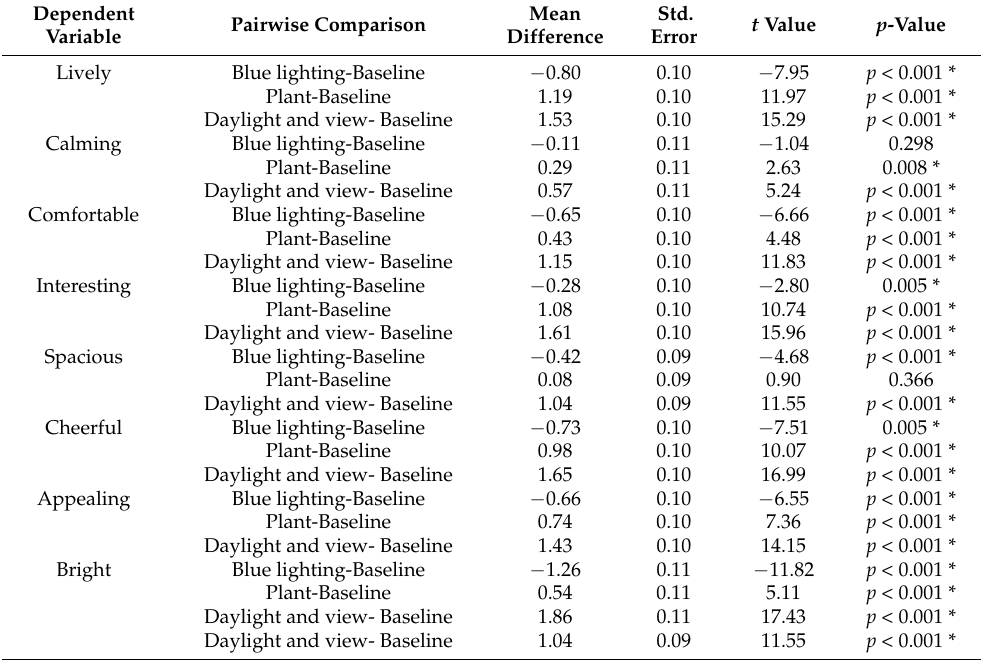
Table 3. Results from the mixed-effect model